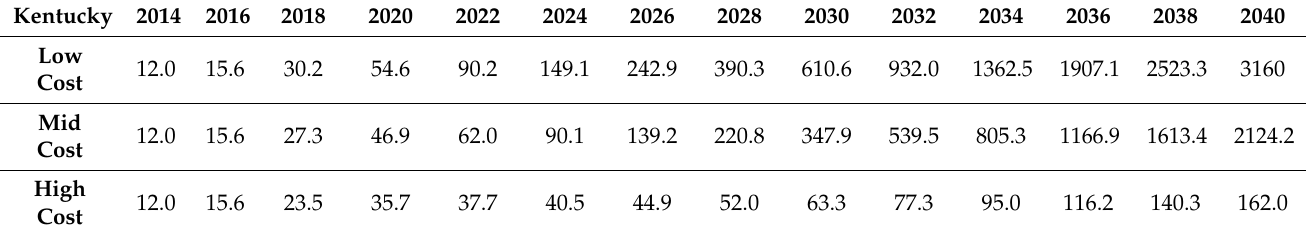
Table 1. Installed DPV capacity (MWdc)and energy generation in Kentucky